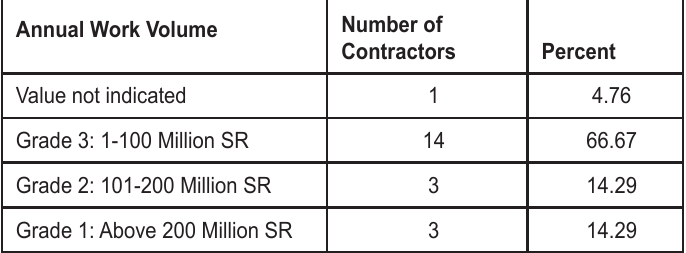
Table 1: Contractors’ annual volume of work